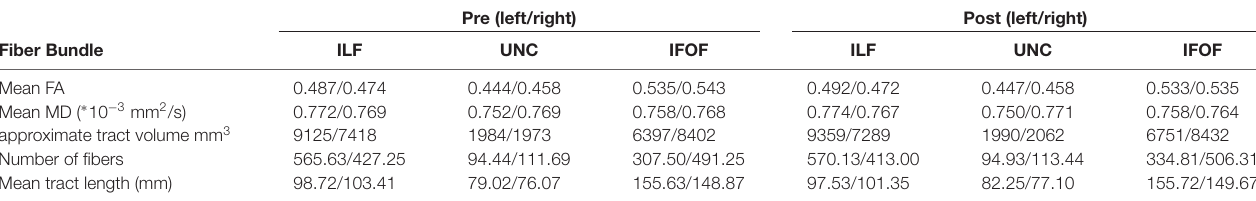
TABLE 1 | Quantitative parameters of the analyzed fiber tracts. Pre (left/right) Post